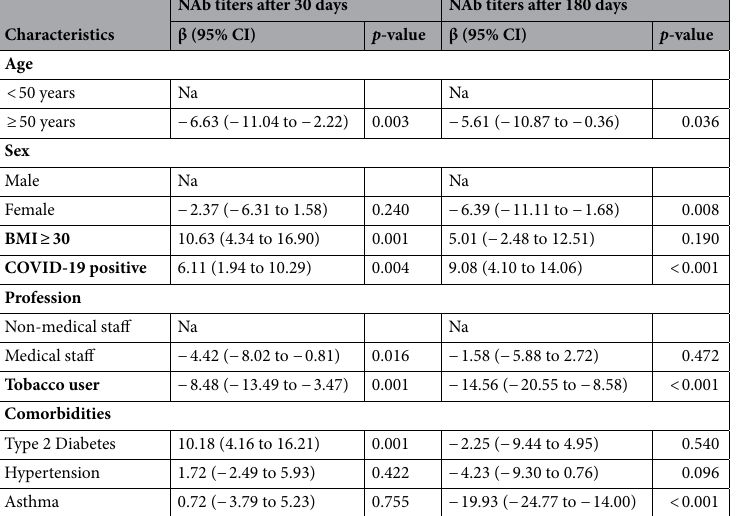
Table 3. Multivariable analyses of NAb titer after 30 days and 180 days of 2nd dosage vaccination. Nab neutralizing antibody, CI confidence